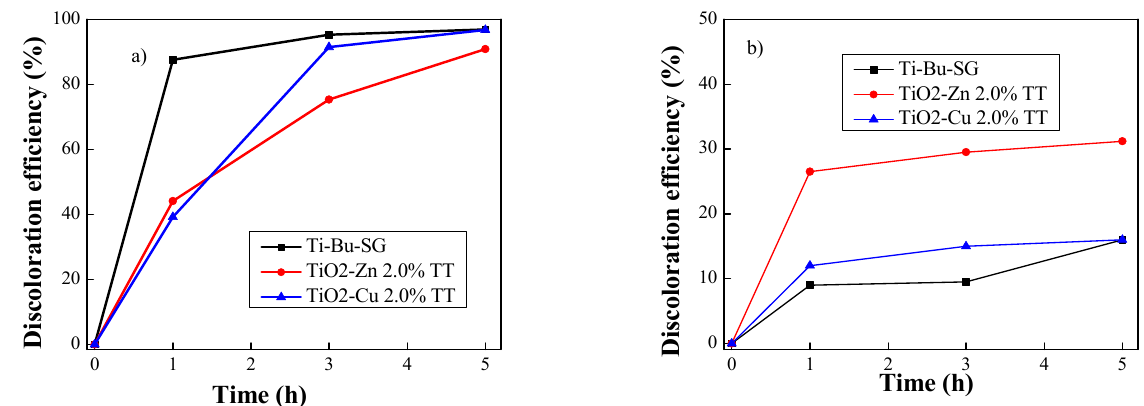
Figure 15. Discoloration of methyl orange under UV ( a ) and visible ( b ) light irradiation using synthesized materials.